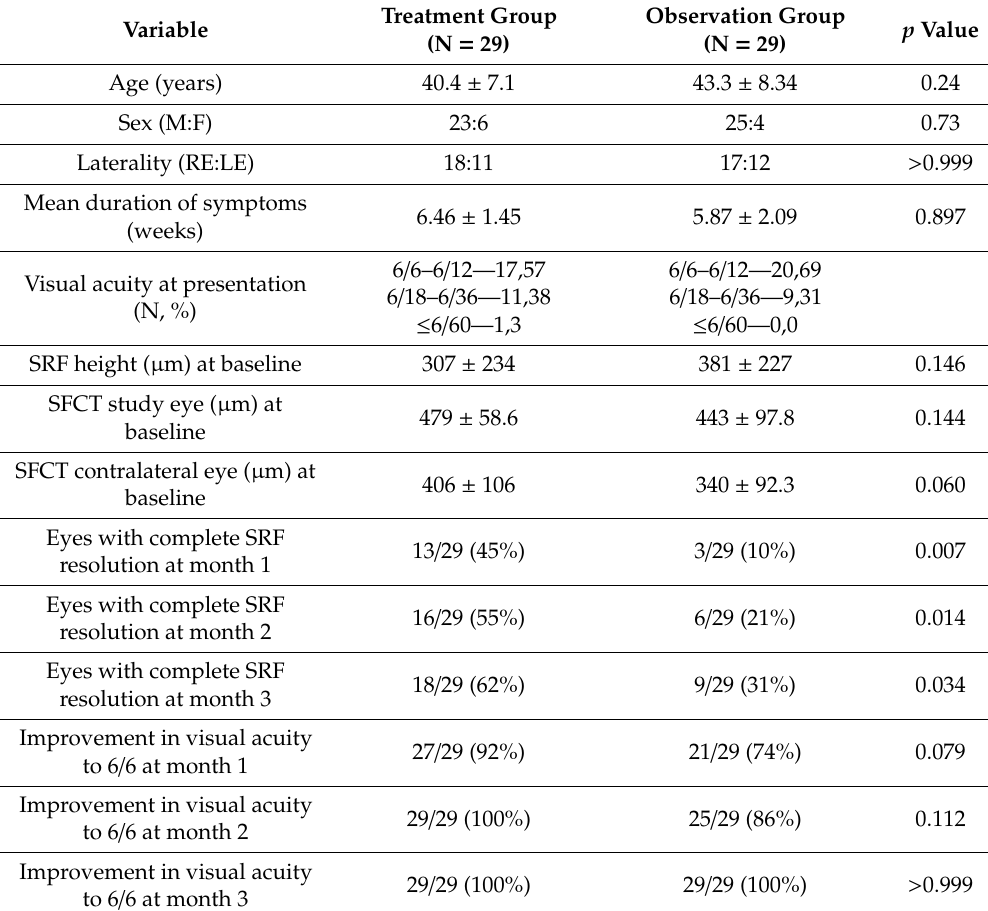
Table 1. Characteristics between the treatment group and observation group in acute